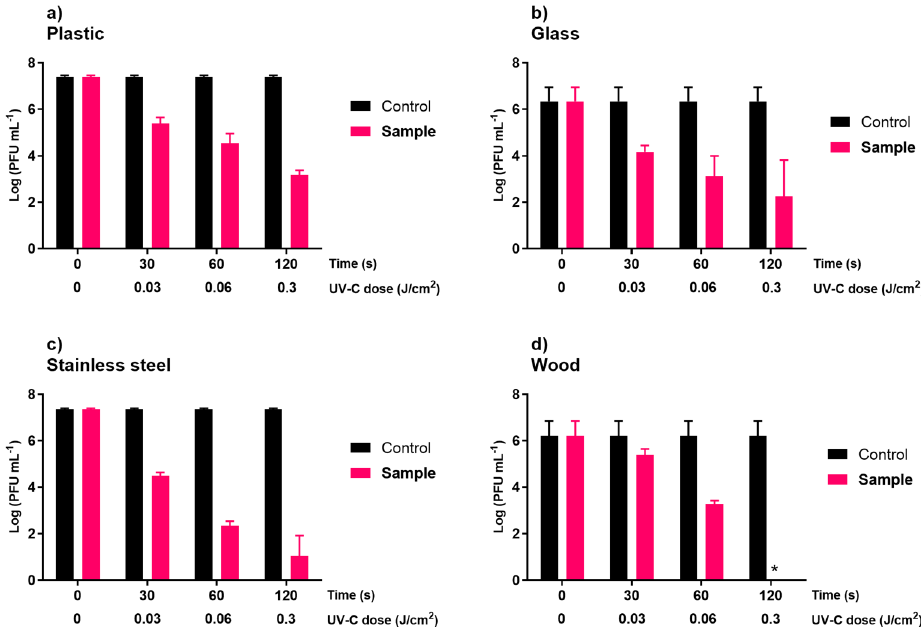
Figure 2. Inactivation of phage ϕ 6 by the UV-C sterilizing chamber (2)2.4W on inanimate surfaces: plastic ( a ), glass ( b ), stainless steel ( c ), and wood ( d ). Limit of detection was about 2.3 log PFU/mL Values represent the mean of the three experiments and error bars represent the standard deviation. * below the methods’ detection limit.